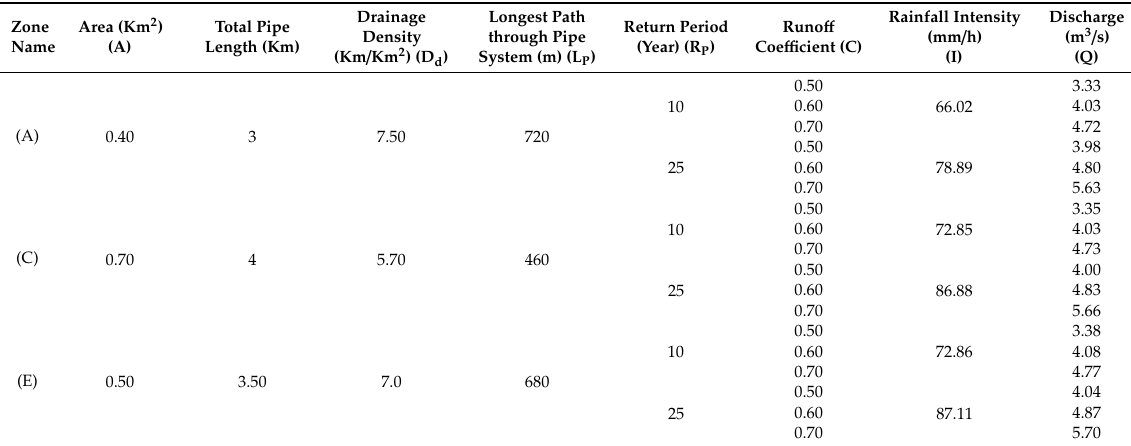
Table 3. Physical data and discharges of studied